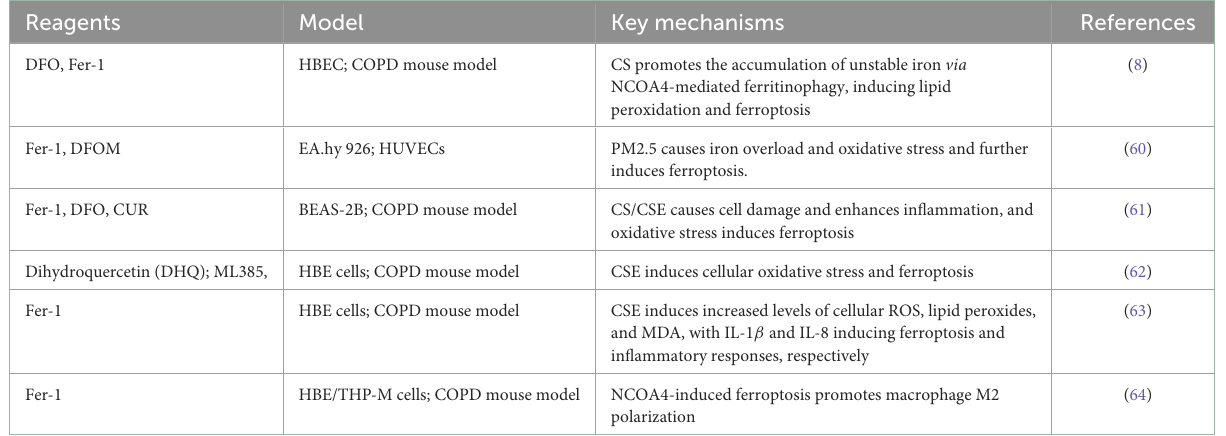
TABLE 1 Mechanism of ferroptosis in